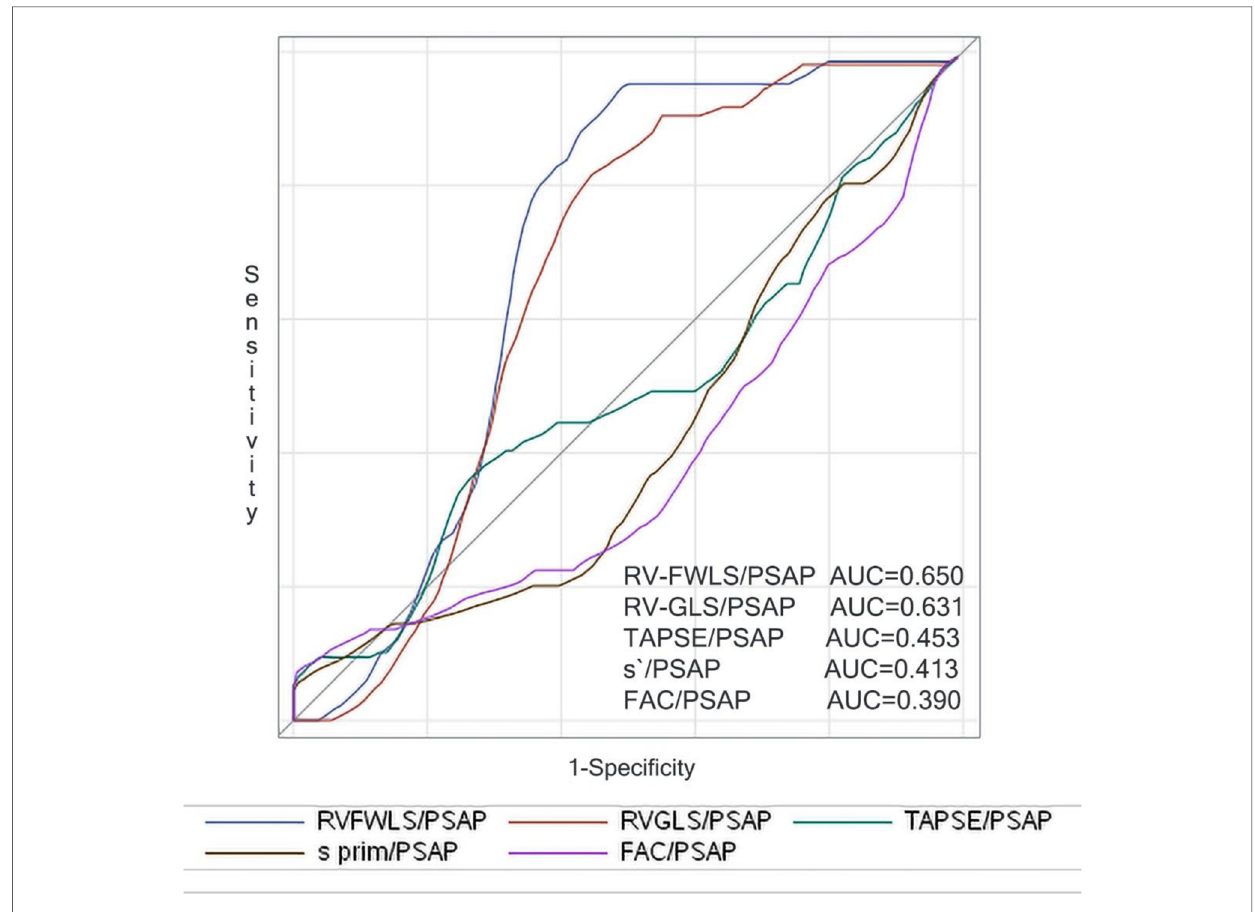
FIGURE 1 Right censored ROC curves for 3-year mortality of the parameters re fl ecting surrogates of baseline RV-PA